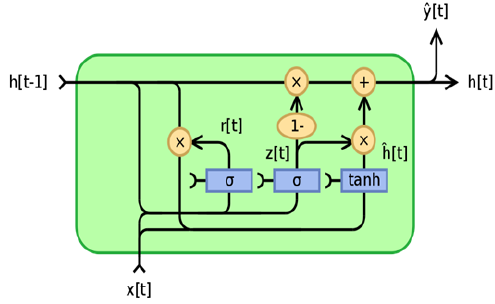
Figure 4. Representation for GRU